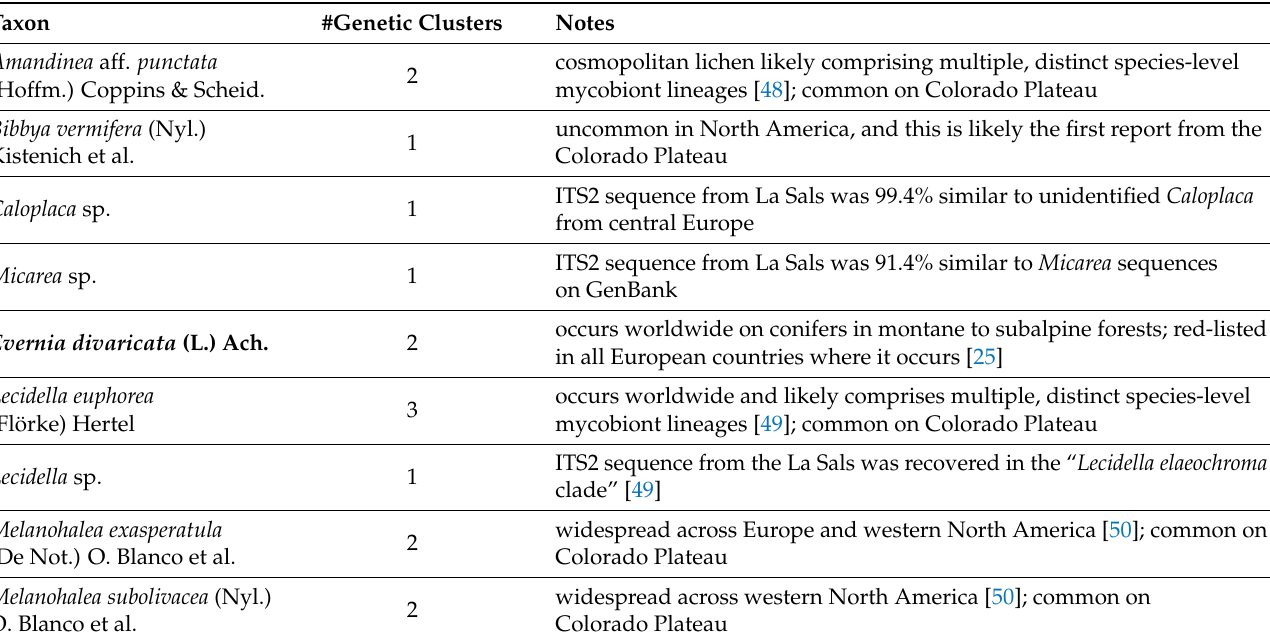
Table 2. List of lichen-forming fungi occurring at a lichen-draped conifer site—“Geyser Pass 2” in the La Sal Mountains, UT, USA. Genetic clusters were inferred from DNA metabarcoding of the ITS2 marker using the FROGS pipeline [39]. Fruticose lichens are shown in bold text; the number of haplotypes, rather than genetic clusters, is reported for Usnea